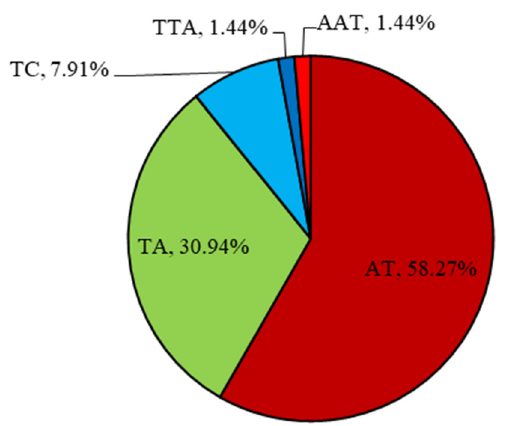
Figure 2. Type and proportion of motif repetition for cpSSRs for eleven different samples of P. suffruticosa .